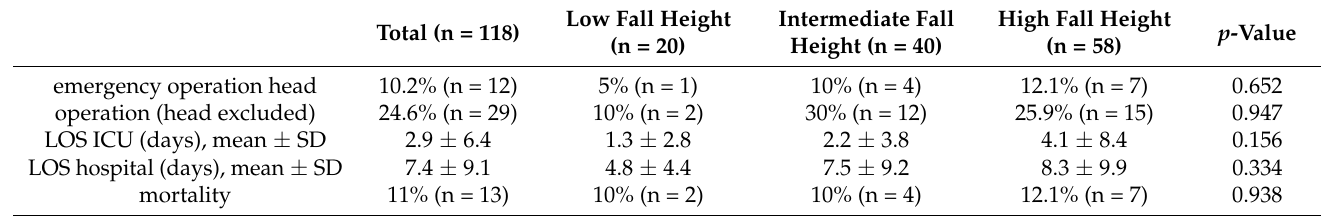
Table 4. Outcome. 4